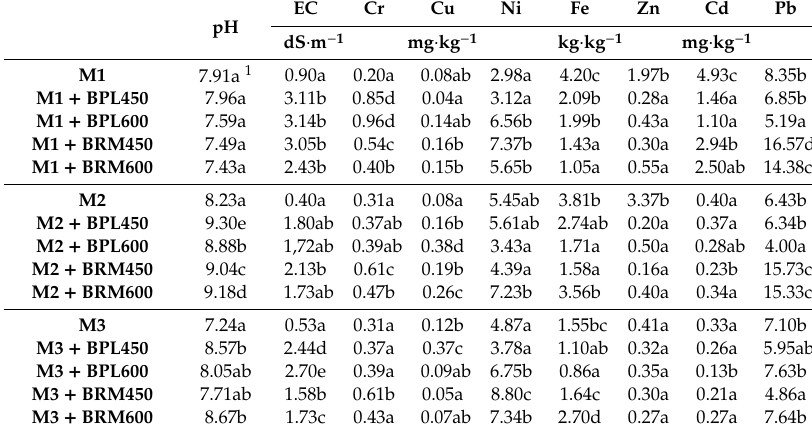
Table 6. pH, electrical conductivity (EC), and mobile metal content in control soils and biochar / soil mixtures from Mijarojos area after 180 incubation